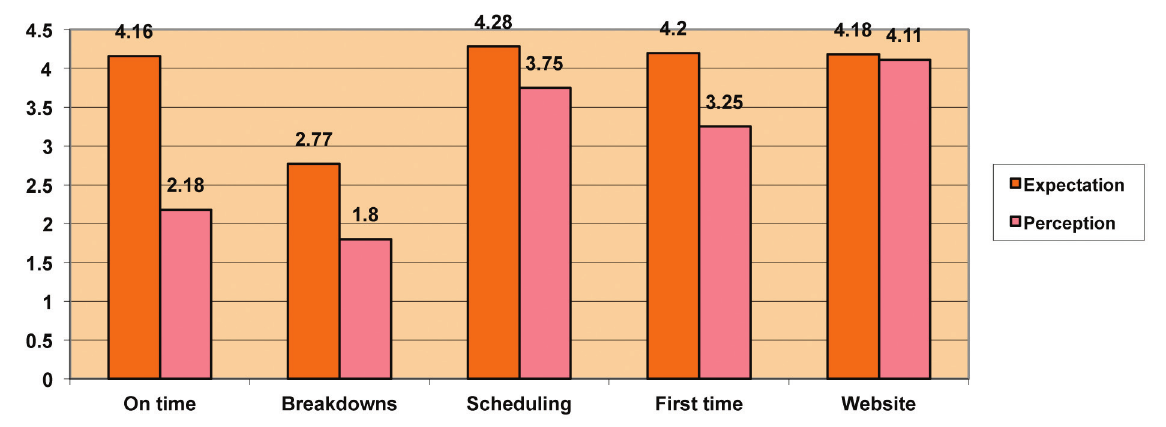
Figure 2: Reliability: Expectations versus